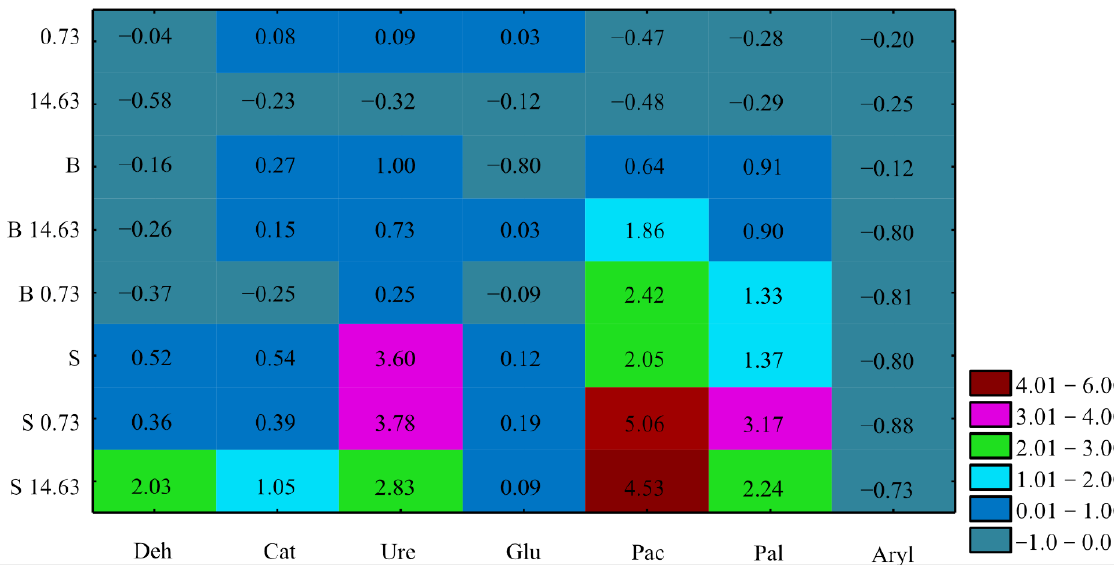
Figure 6. Impact index (IF) of the Successor T 550 SE, bentonite and straw on the enzymatic activity of soil. Glu—β-glucosidase; Aryl—arylsulfatase; Pac—acid phosphatase; Pal—alkaline phosphatase; Ure—urease; Cat—catalase; Deh—dehydrogenases.; B—bentonite; S—straw; herbicide dose: 0; 0.73; 14.63 mg a.s./kg soil; a.s.—active substance.